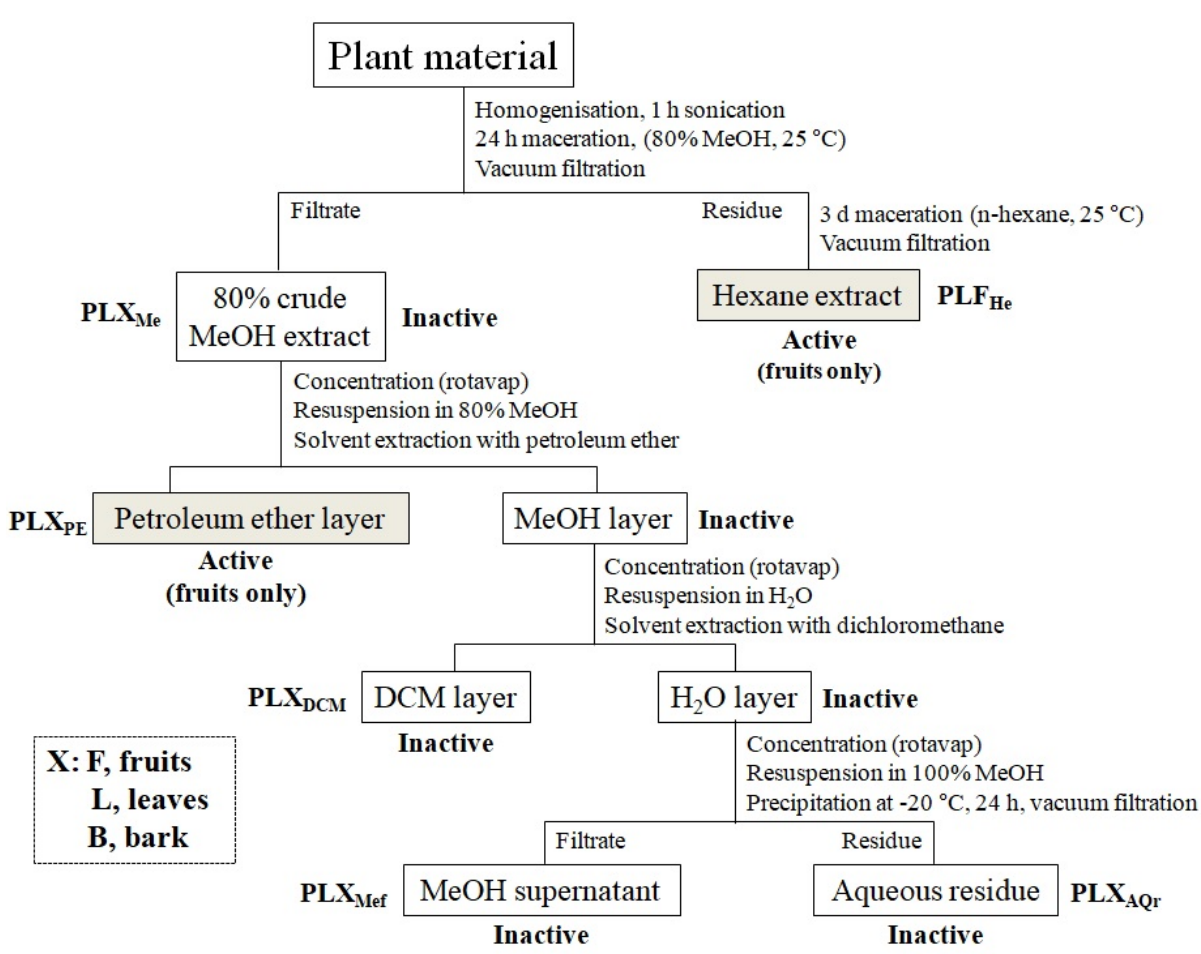
Figure 1. Overview of the initial purification scheme of fruits (PLF), of P. lentiscus , and the respective insecticidal activity of each fraction on L. botrana